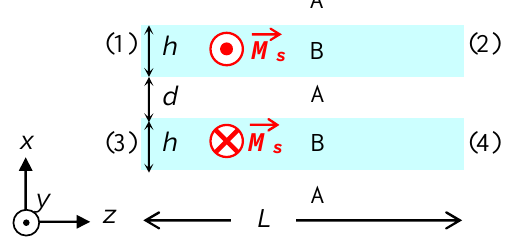
Fig. 1. System of two coupled bigyrotropic slab waveguides (1) in the “anti-parallel” transverse magnetic configuration. The width of both magnetic guiding layers (B) is h , that of the dielectric isotropic spacer (A) is d . L denotes the interaction length. The input-output ports are numbered from (1) to (4).